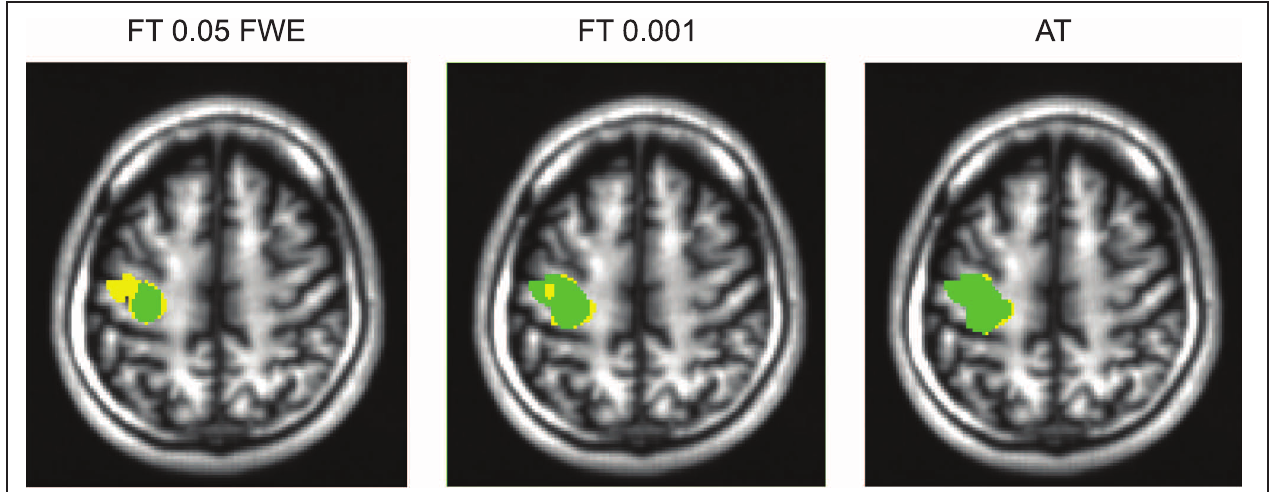
FIGURE 6 | Thresholded statistical maps of the first subject used in Figure 5. Voxels in green were labeled active in both sessions. Voxels in yellow were labeled active only in of the sessions (and non active in the other). More yellow voxels indicate bigger between session variance and smaller test–retest